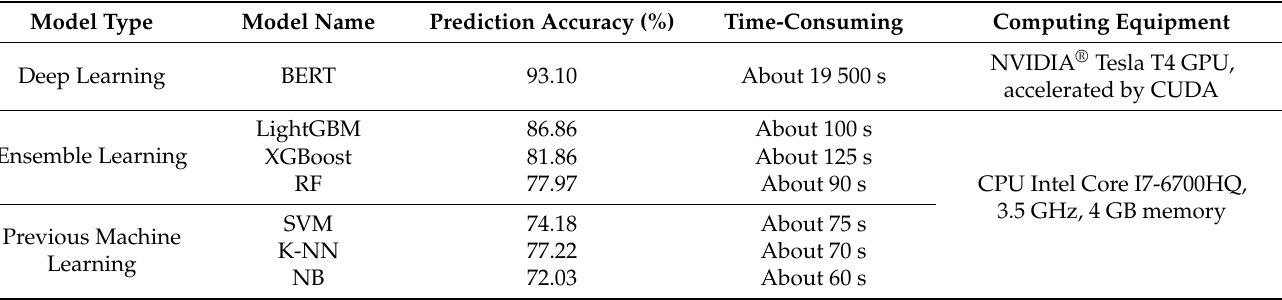
Table 5. Comparison of different types of models in this